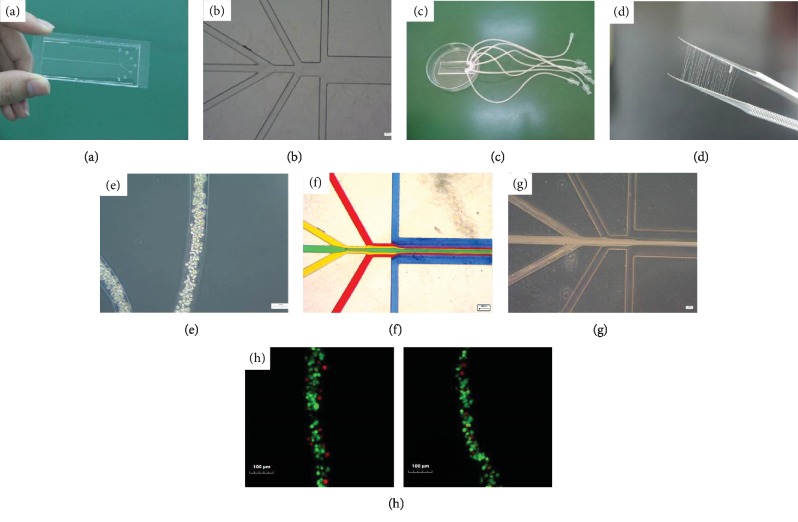
Production of microfluidic chips, synthesis of hepatic plate-mimetic 3D liver tissue hydrogels, and validation hepatic plate mimetic arrangement. Actual chip (a), Microchannels inside the chip as imaged with a CK-2 microscope (Olympus, Japan) (b), chip after connecting to the tubing (c), external appearance of hydrogel micelles (d), microscopic observations of a hydrogel micelle (e), simulation of laminar flow distribution (f), laminar flow distribution of actual liquids in the chip (g), and real-time dual fluorescent labeling of live cells (h), showing the hepatic plate-mimetic 3D culture group (left) and the mixed 3D culture group (right, green fluorescent Calcein-AM-labeled C3A cells, red fluorescent Mito-Red-labeled EA.hy926 cells). All scale bars represent 100 μm.